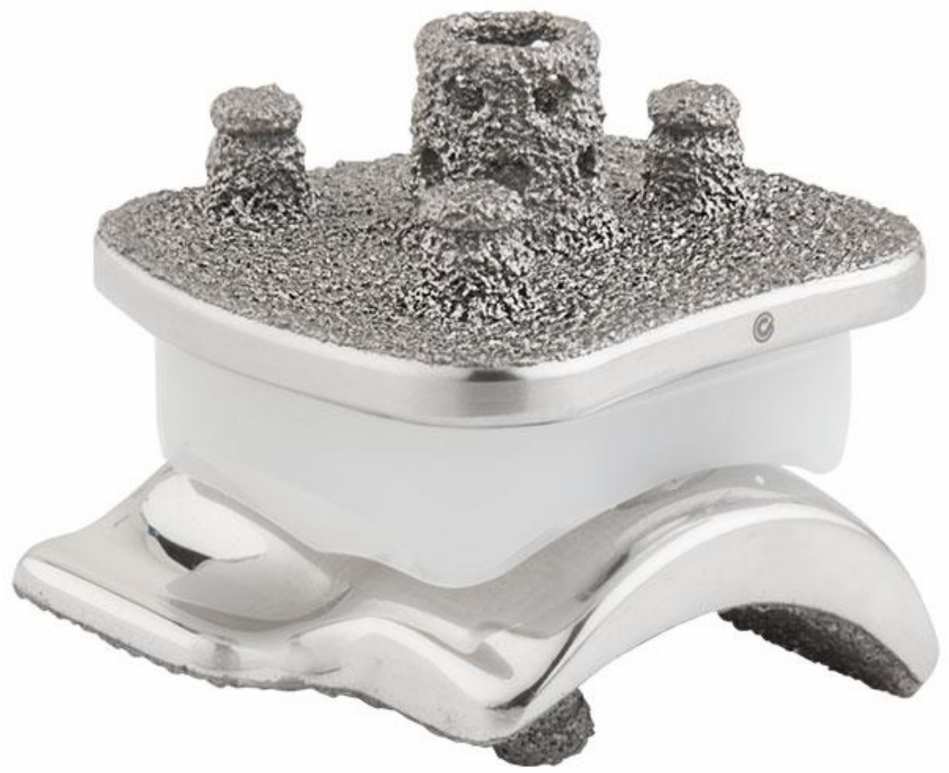
Figure 1. VANTAGE Mobile Bearing Total Ankle